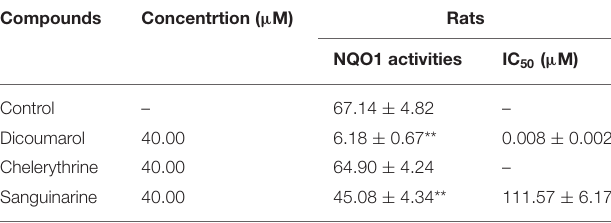
TABLE 5 | Effect of compounds on rat cytosolic NAD(P)H: quinone oxidoreductase activities.